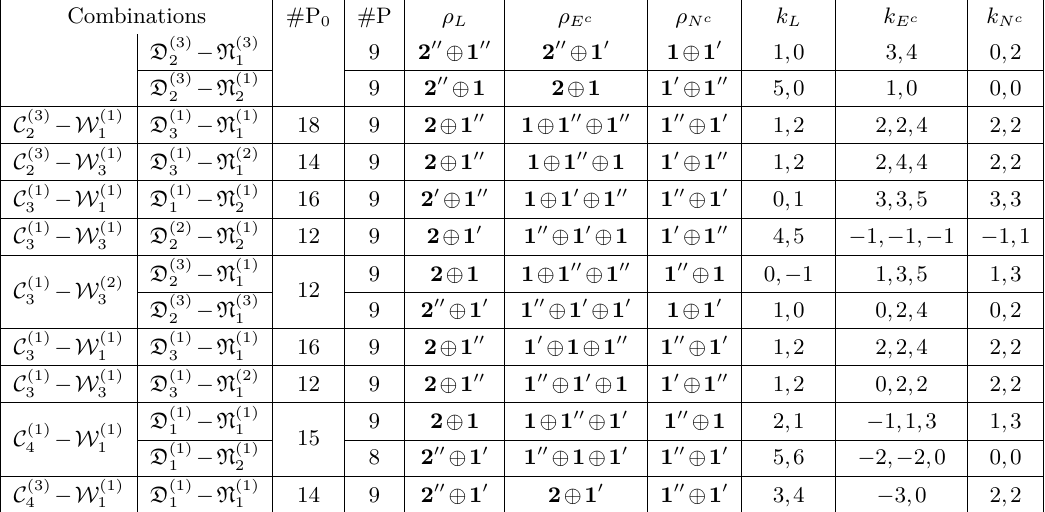
Table 24. The same as in table 22 but for IO neutrino mass